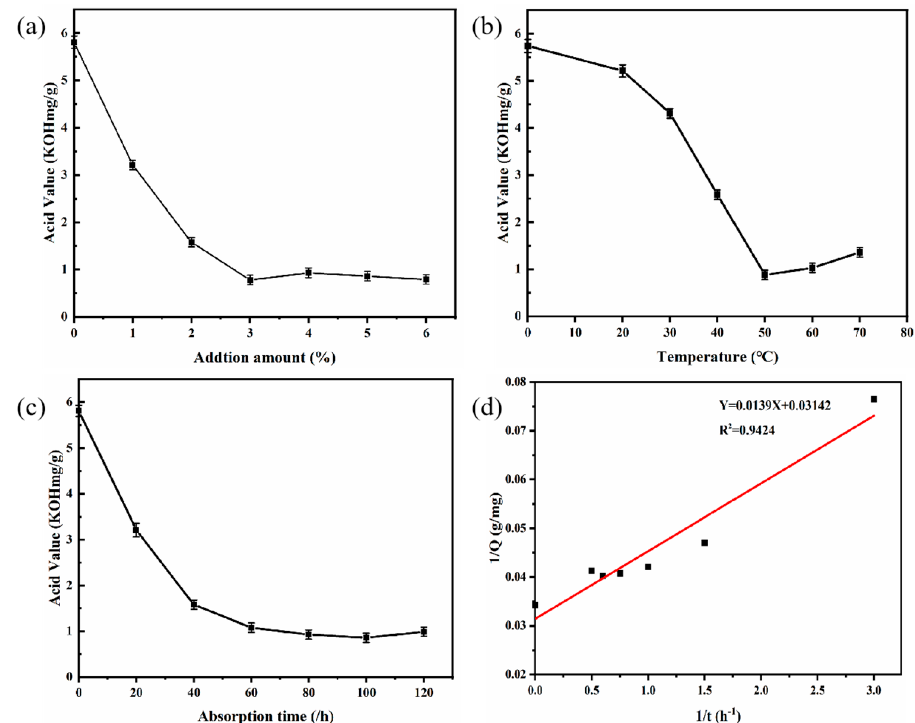
Figure 3. Effects of additional amounts of AMC fiber ( a ); adsorption temperature ( b ); and adsorption time ( c ) on deacidification. And 1/Q; 1/t ( d ) (pseudo-first-order rate model). AMC: Adsorbent-alkali microcrystalline cellulose.